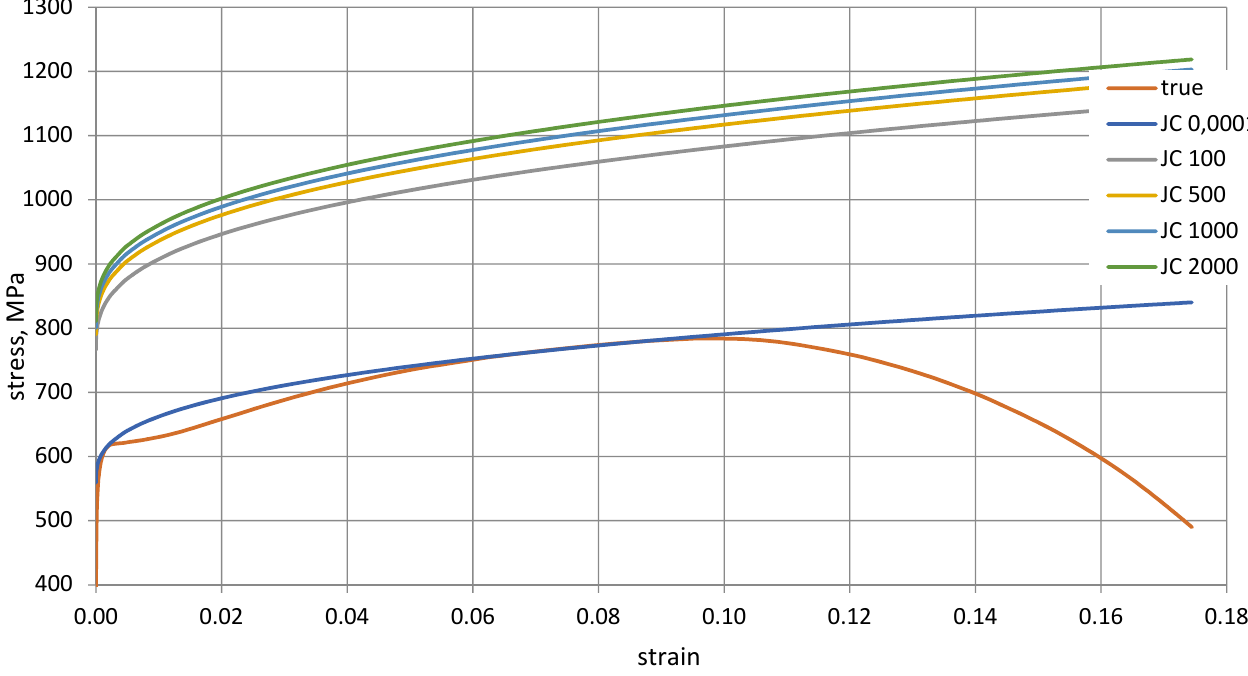
Figure 8. Johnson–Cook model of HY 80 steel as a function of strain rate, C = 0.0268. The values for the temperature component can be taken based on the literature